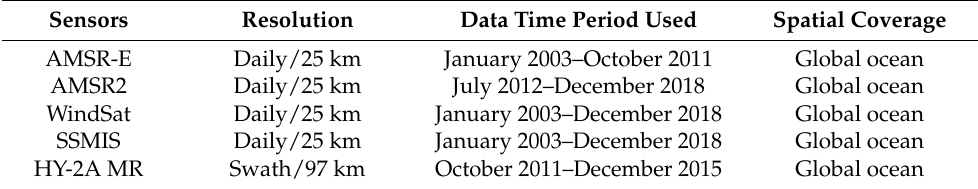
Table 1. Satellite radiometer remote sensing data of water vapor.